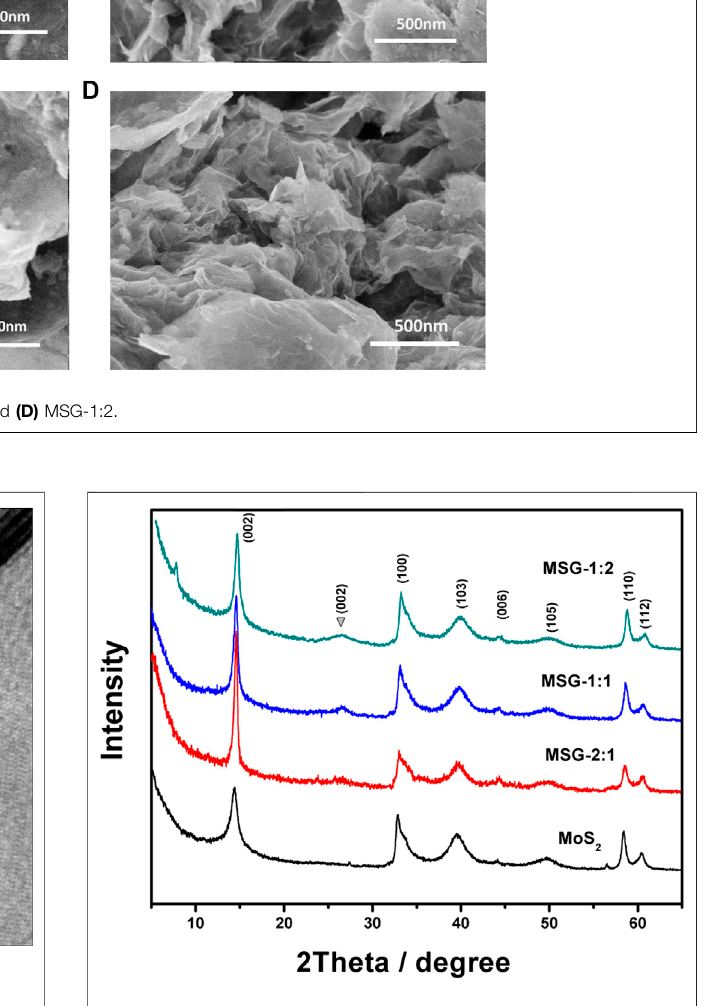
FIGURE 3 | XRD patterns of MSG-2:1, MSG-1:1, MSG-1:2, and MoS 2